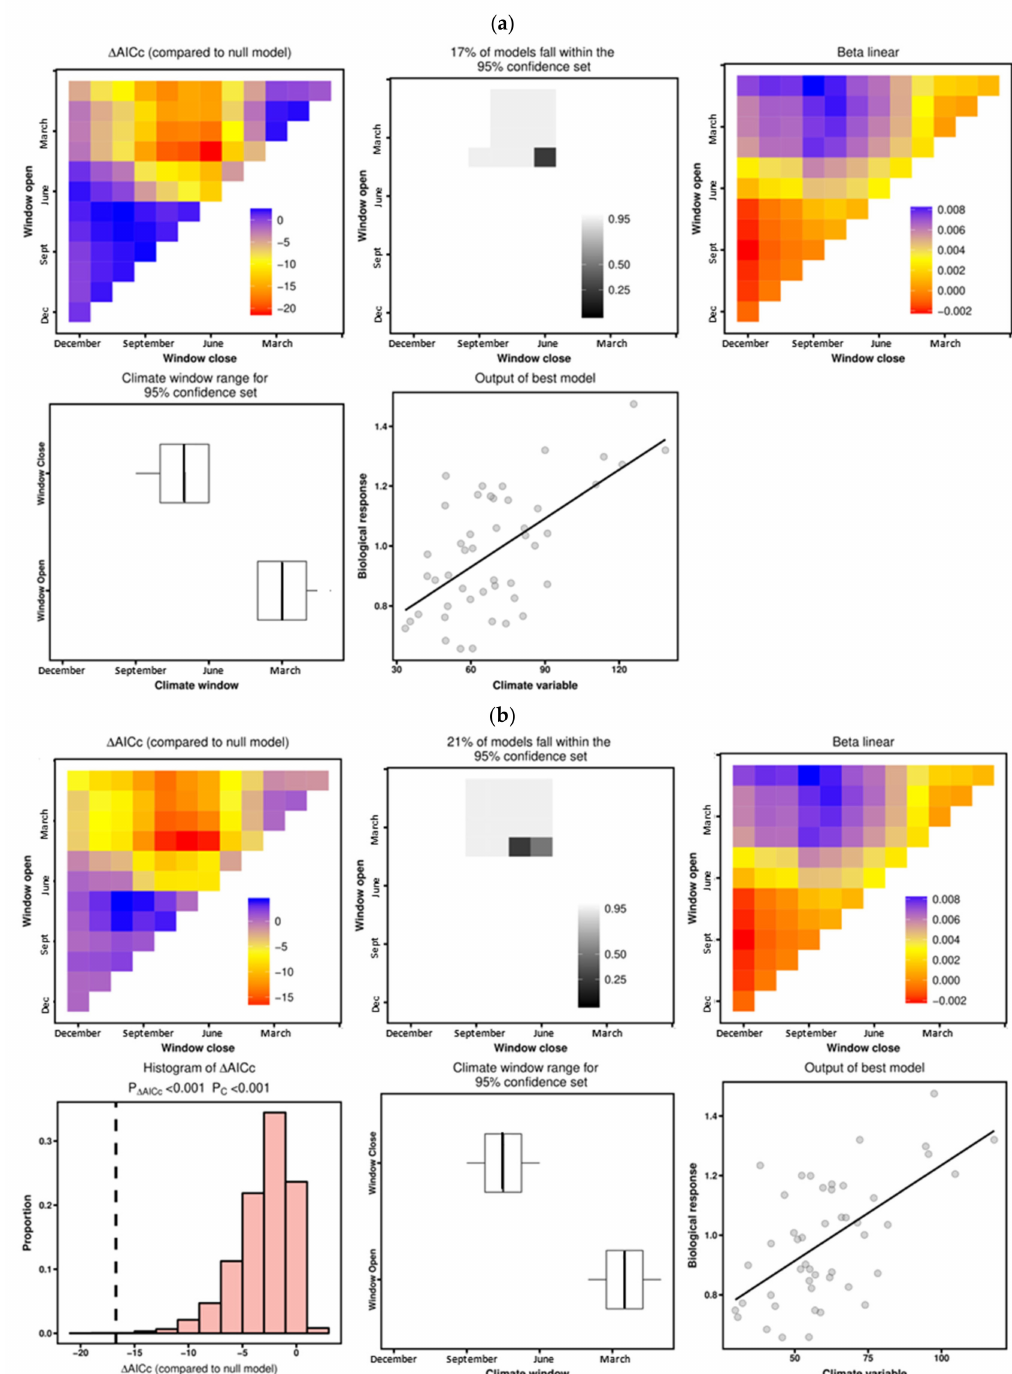
Figure 6. Examples of “ climwin” output panels by calculating ( a ) linear models without and ( b ) with K-fold cross-validation and randomization method. The example corresponds to precipitation and the Pistacia terebinthus chronology. The model was significant ( p < 0.05) according to randomization tests (histogram of ∆ AICc values; the vertical dashed line shows the ∆ AICc of the best model fitted on the observed